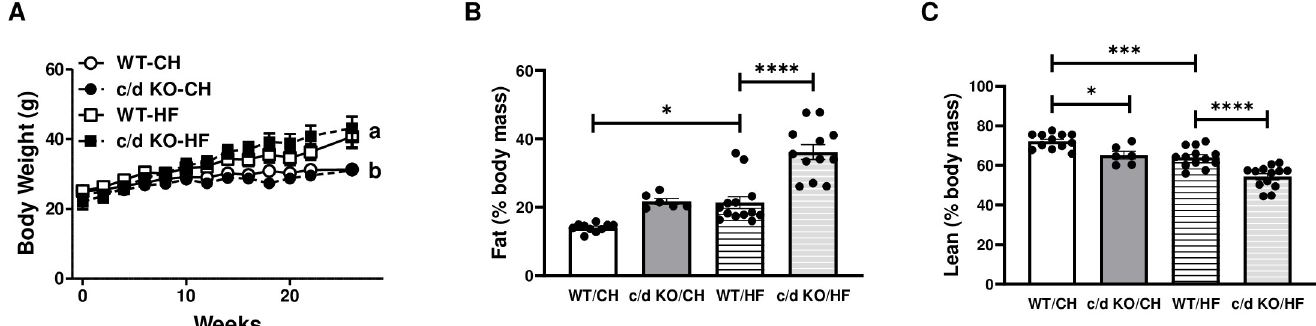
Fig 2. Effect of high-fat (HF) diet on miR-181c/d -/- (c/d KO) mice. (A) Body weight (n = 4/genotype/diet), (B) percent fat mass (n = 8-13/genotype/diet), and (C) percent lean mass (n = 8-13/genotype/diet) were measured before and during the 26 weeks of HF diet. Data are expressed as mean ± SEM. � p < 0.05 by Bonferroni post hoc analysis after intergroup differences were found by 1-way ANOVA. � p < 0.05, ��� p < 0.001, ���� p < 0.0001 by two-sample t-test.